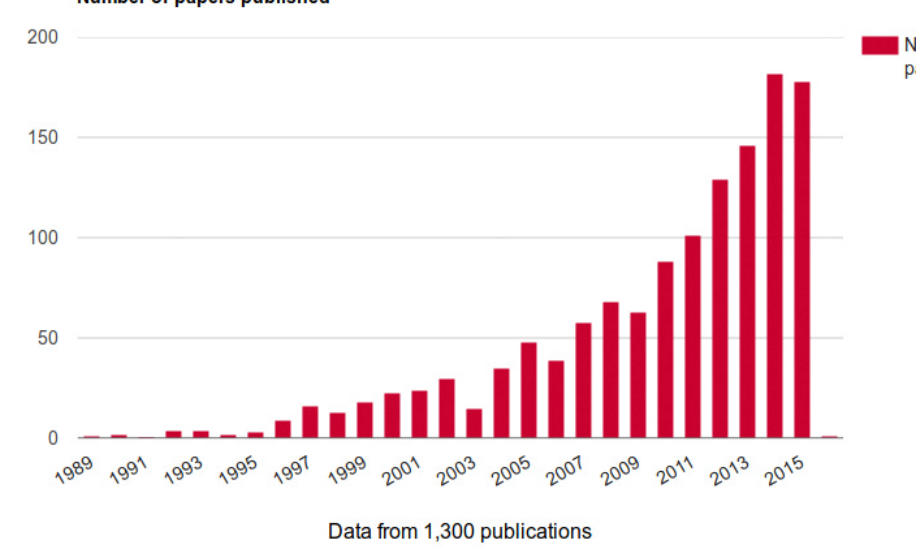
Figure 2. Number of publications per year in